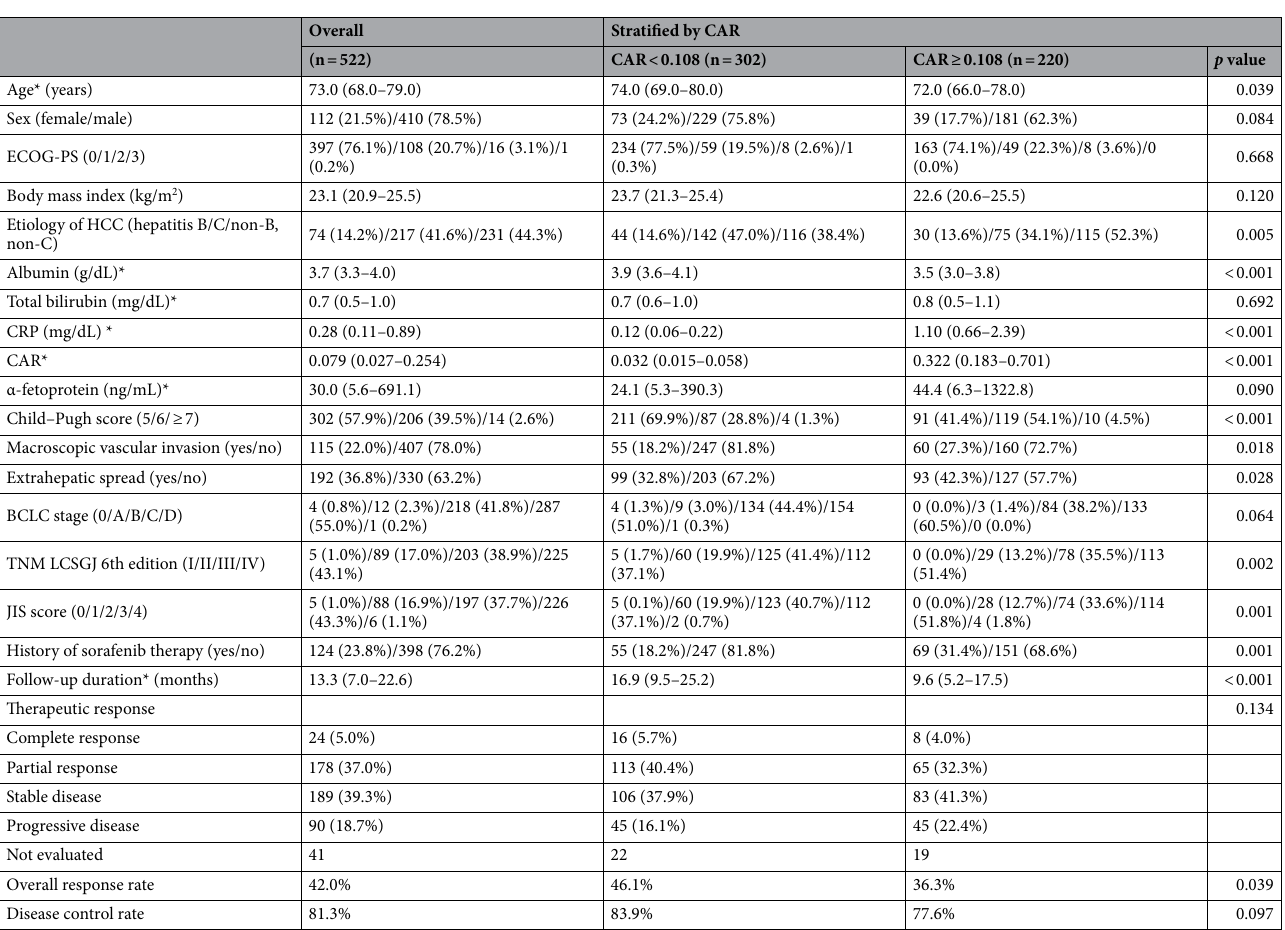
Table 1. Characteristics of the study patients. ECOG-PS Eastern Cooperative Oncology Group performance status; HCC Hepatocellular carcinoma; CRP C-reactive protein; CAR C-reactive protein to albumin ratio;